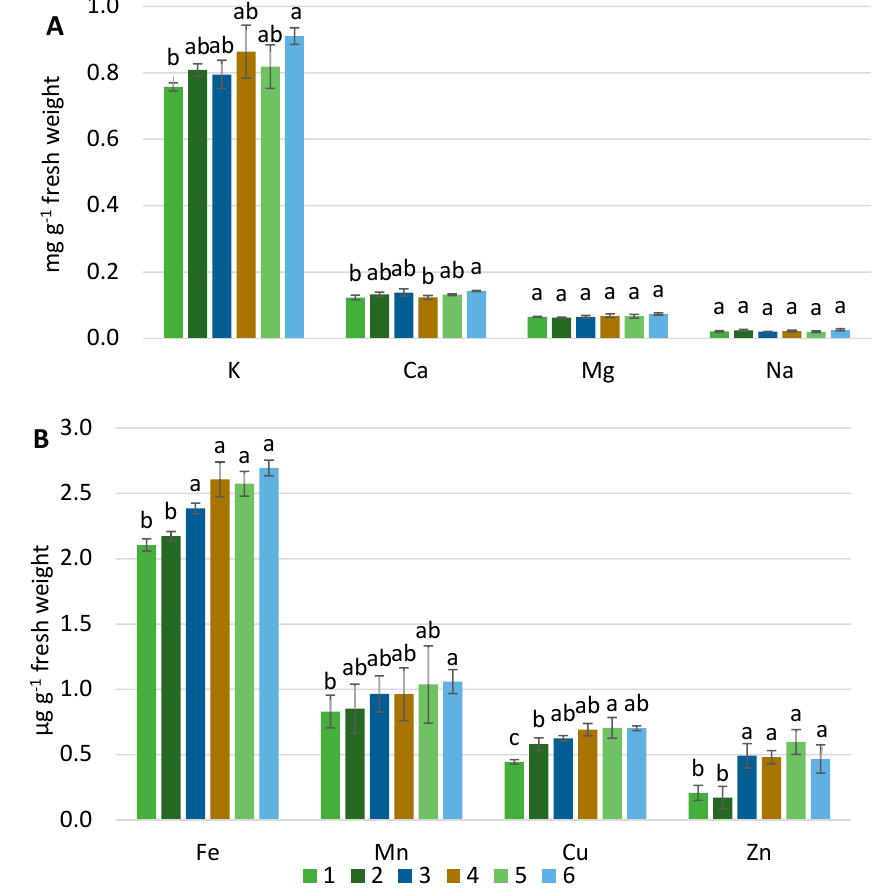
Figure 4. Influence of agrotechnological tools on major ( A ) and trace ( B ) elements in cv. Rubin apples on harvest time (commercial ripening) in average of three years. 1. Each year hand pruning forming slender spindle (control); 2. Mechanical pruning (each year); 3. Trunk incision using chain saw + mechanical pruning (each year); 4. Mechanical pruning (each year) + spraying with calcium- prohexadione; 5. Mechanical pruning + hand pruning + summer pruning; 6. Mechanical pruning one side, changing sides annually. Averages followed by different letter within the same compound indicate significant differences according to the Duncan’s least significant difference test ( p < 0.05). Error bars show standard deviation. The PCA scatterplot show an average coordinate of carbohydrates, phenolic com- pounds, antioxidant activity, macro and micro elements in cv Rubin fruits when apple trees were treated (with hand pruning, mechanical pruning and mechanical pruning with additional tools (Figure 5). The first two factors (F1 vs. F2) of the PCA, explained 49.30%